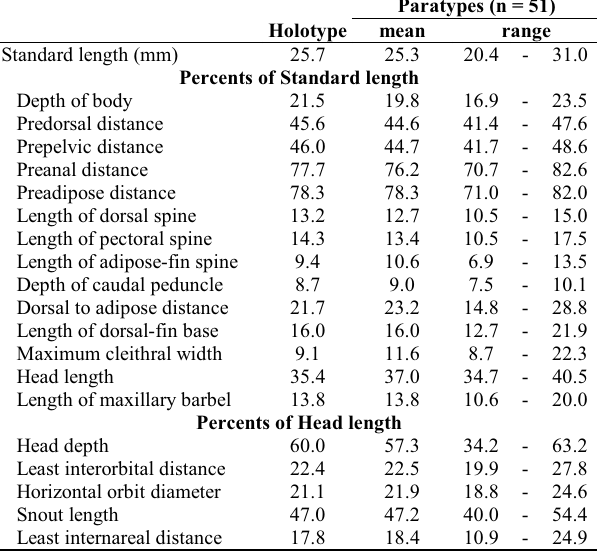
Table 1. Morphometric data of holotype and paratypes of Aspidoras psammatides .